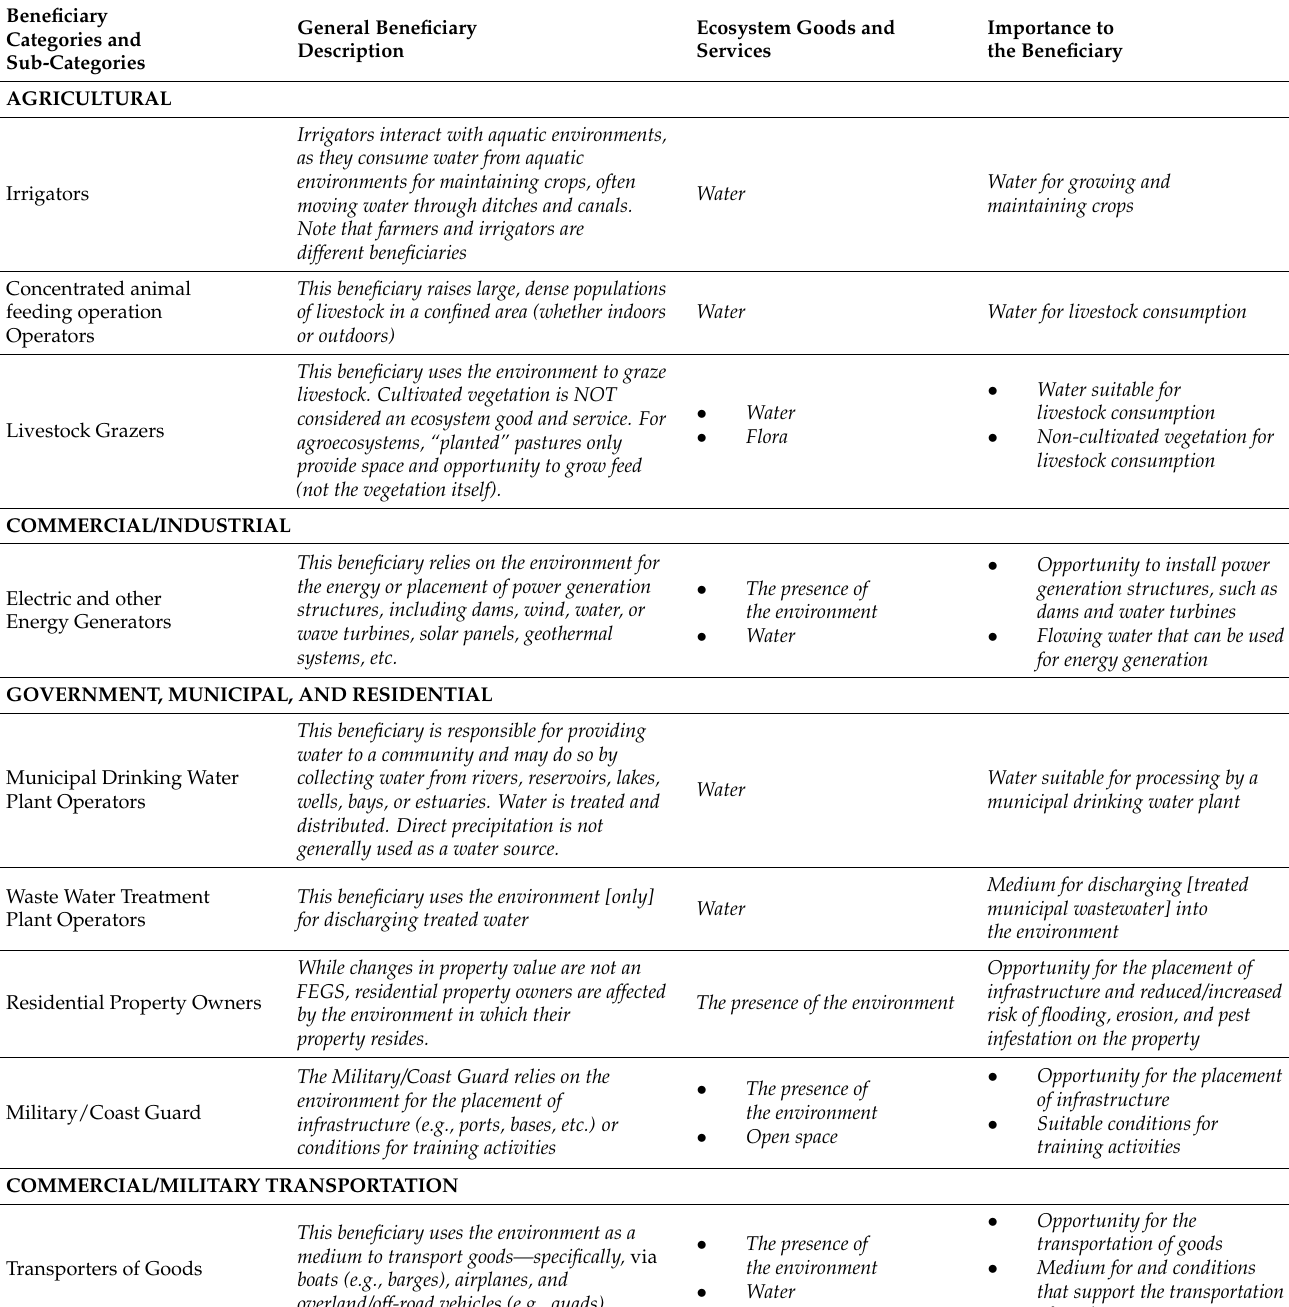
Table 1. Matrix A: The description and importance of beneficiary categories and subcategories. Source: Information selected and transcribed from the U.S. EPA. Final Ecosystem Goods and Services Classification System (FEGS-CS)